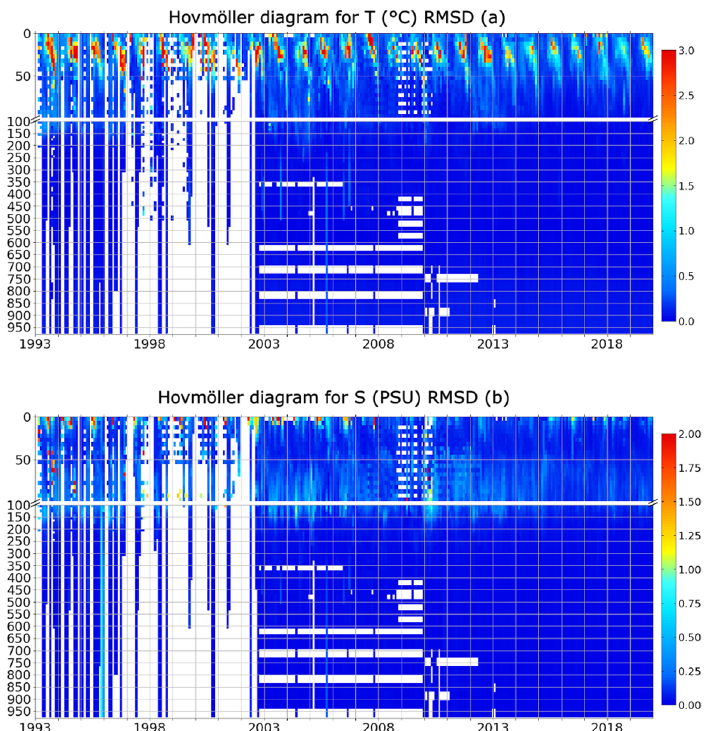
Figure 6. Hovmöller diagrams of root mean square difference for temperature in ◦ C ( a ) and salinity in PSU ( b ), by comparing the BS-PHY MY results with in situ profilers in the Black Sea domain from 1 January 1993 to 31 December